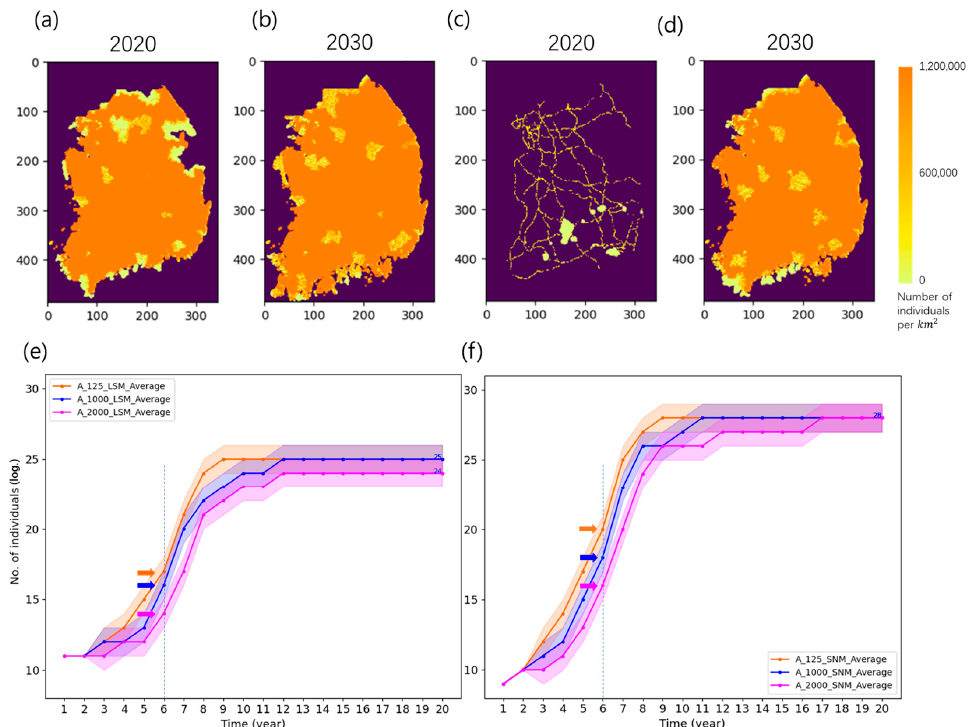
Figure 8. Simulating advancement patterns of WCSB populations with different Allee-effect thresh- olds ( A ) in the southern Korean peninsula in 2011–2030, with A = 125 individuals per spatial unit in 2020 ( a ) and 2030 ( b ), and with A = 2,000 individuals per spatial unit in 2020 ( c ) and 2030 ( d ). (Hor- izontal and vertical units in two-dimensional maps are expressed in km for convenience of illustra- tion.) Changes in population size (log.) of the WCSB with different A ( γ = 0.25) with 125, 1,000, and 2,000 individuals per spatial unit in the southern Korean peninsula between 2010 and 2030 accord- ing to LSM ( e ) and SNM ( f ). Arrows in ( e , f ) indicating the number of individuals matching different levels of A in the sixth year.